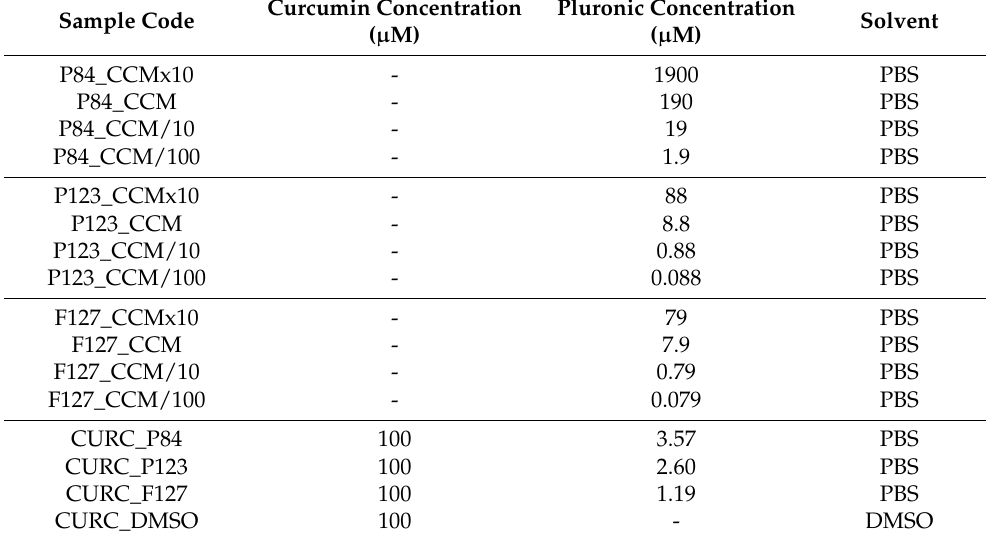
Table 1. Composition of the Pluronic and CURC solutions investigated as membrane